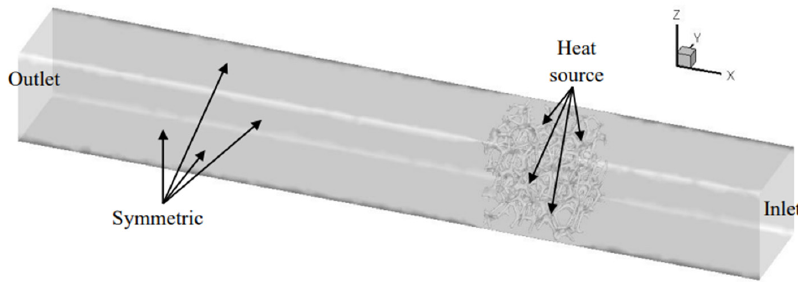
Figure 2. Compute region and boundary conditions.